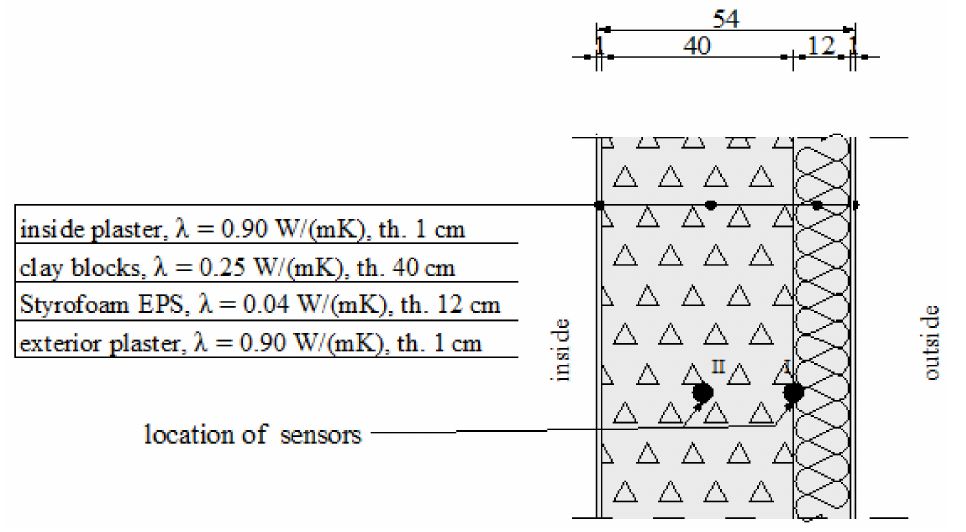
Figure 2. Two-layer wall cross section.